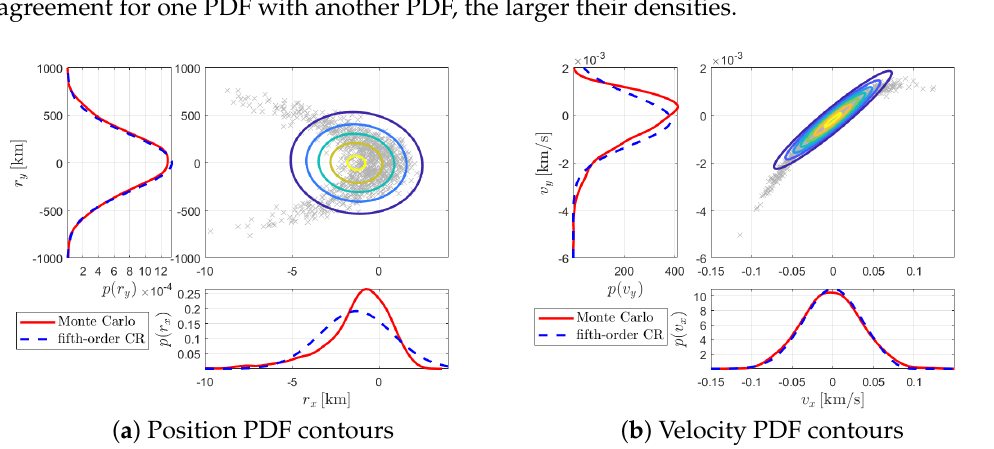
Figure 4. PDF contours using fifth-order CR with Monte Carlo samples of HEO case.